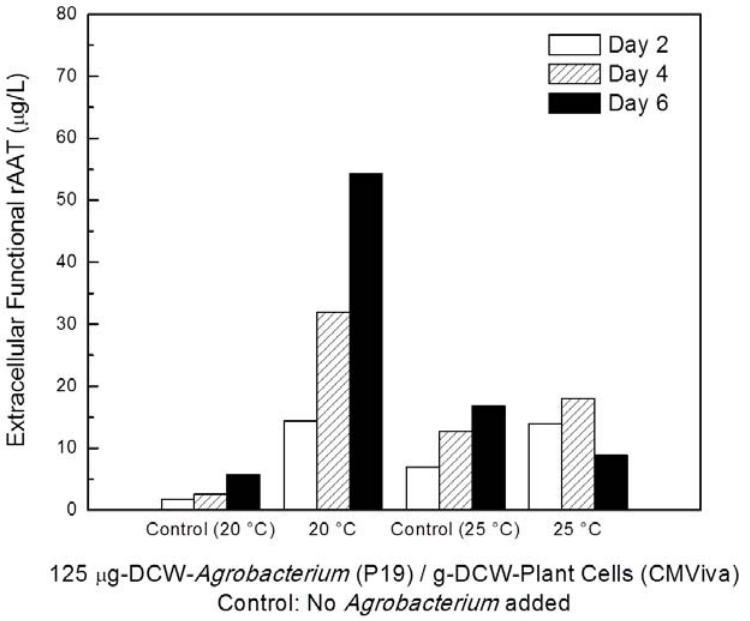
Figure 2. The kinetics of functional rAAT protein production for transgenic plant cells (CMViva) co ‐ cultivated with Agrobacterium (P19) in a 6 well ‐ microplate at 20 °C or 25 °C. Transgenic CMViva cell culture without the co ‐ cultivation of recombinant Agrobacterium was investigated as control. The biomass ratio of Agrobacterium to plant cells was 125 μ g ‐ DCW/g ‐ DCW. Samples were taken on days 2, 4 and 6 post ‐ induction.